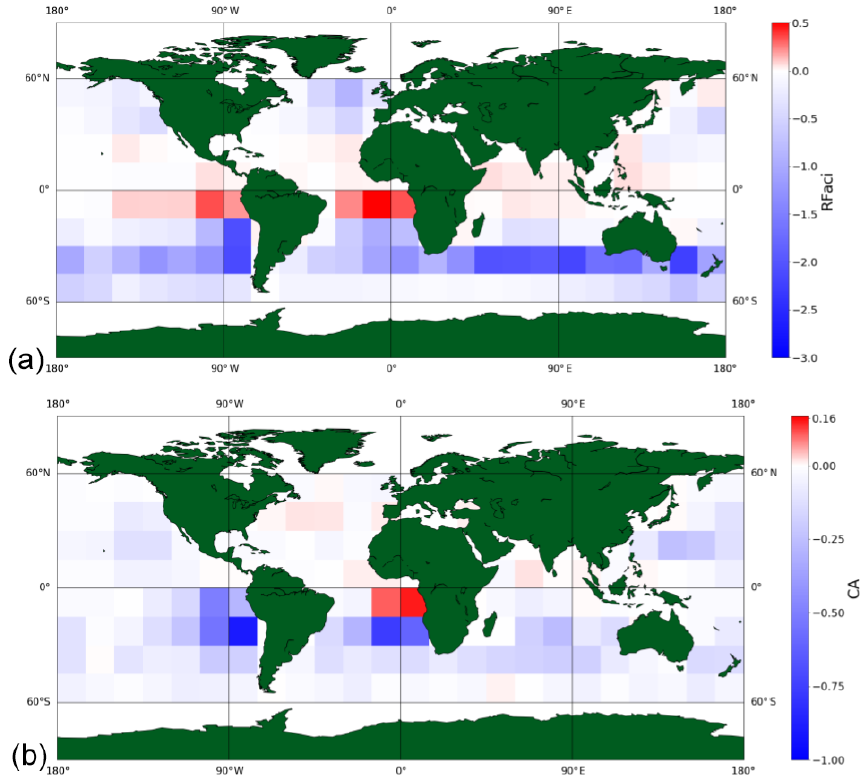
Figure 6. (a) The radiative forcing due to aerosol–cloud interactions (RFaci) ( − 0 . 21 ± . 12Wm − 2 ) and (b) cloud adjustments ( − 0 . 05 ± 0 . 03Wm − 2 ) found on a regional basis with constraints on LWP, EIS, and RH 700 without weighting by area. Note the color bar for (b) CA warm is 1 / 3 of the magnitude of (a) RFaci warm .